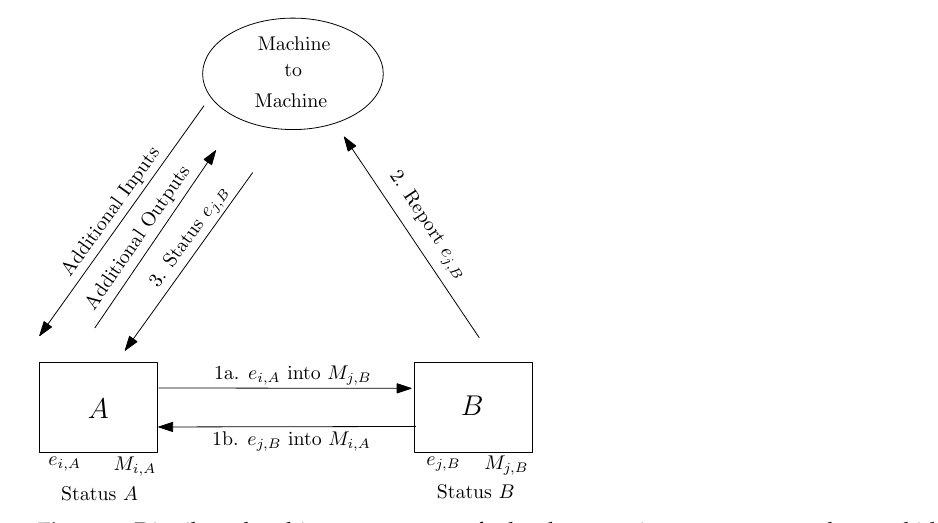
Figure 2. Distributed architecture to report faulty drones using anonymous ephemeral identifiers. In contrast to the approach depicted in Figure 1, drones exchange lists of ephemeral identities and locally update their status without the necessity of central intermediary services. The main differences with respect to the centralized version are in Steps 2 and 3, which are conducted now in a machine-to-machine